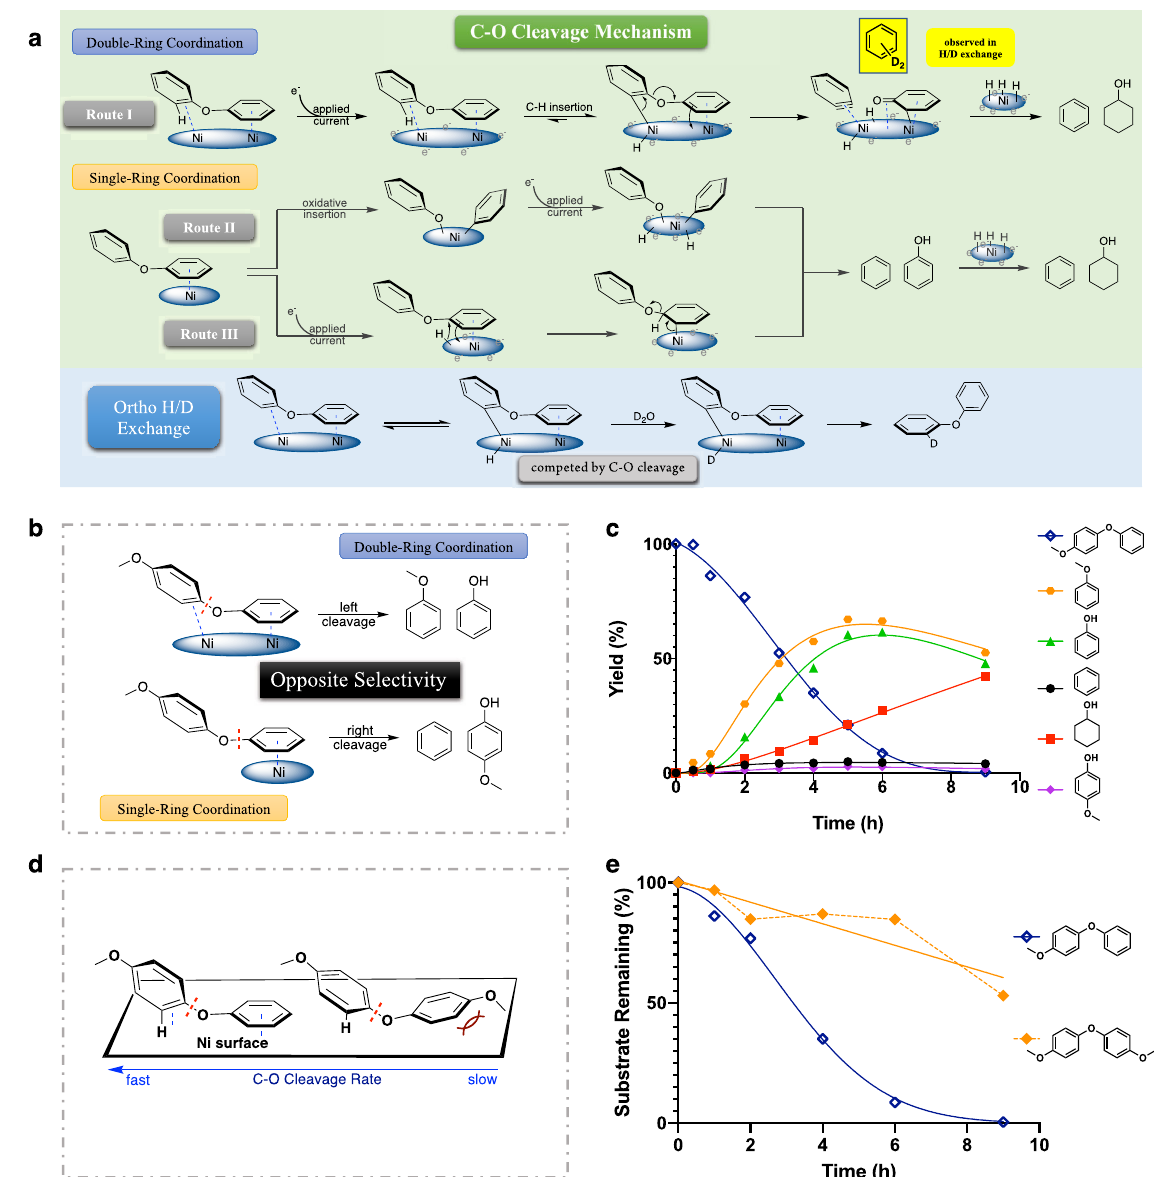
Fig. 3 Identi fi cation of the major C-O cleavage mechanism for diphenyl ether. a Proposed C-O cleavage and H/D exchange mechanisms of diphenyl ether. b Asymmetric diphenyl ethers differentiate the proposed cleavage mechanisms. c ECH of para-methoxylated diphenyl ether over skeletal nickel electrode under standard condition (50 mA, 60 °C, 33% v/v IPA). For the initial substrate, “ yield ” represents the percentage of starting material recovered at each time point. d Double ring coordination requires both perpendicular and parallel bindings. e Reactivity comparison between 4-phenoxyanisole and bis-4-methoxyphenyl ether. For additional time courses and product analyses see supplementary Fig. 69. The dotted orange line highlights the variability in analysis due to borderline solubility of this substrate in the reaction